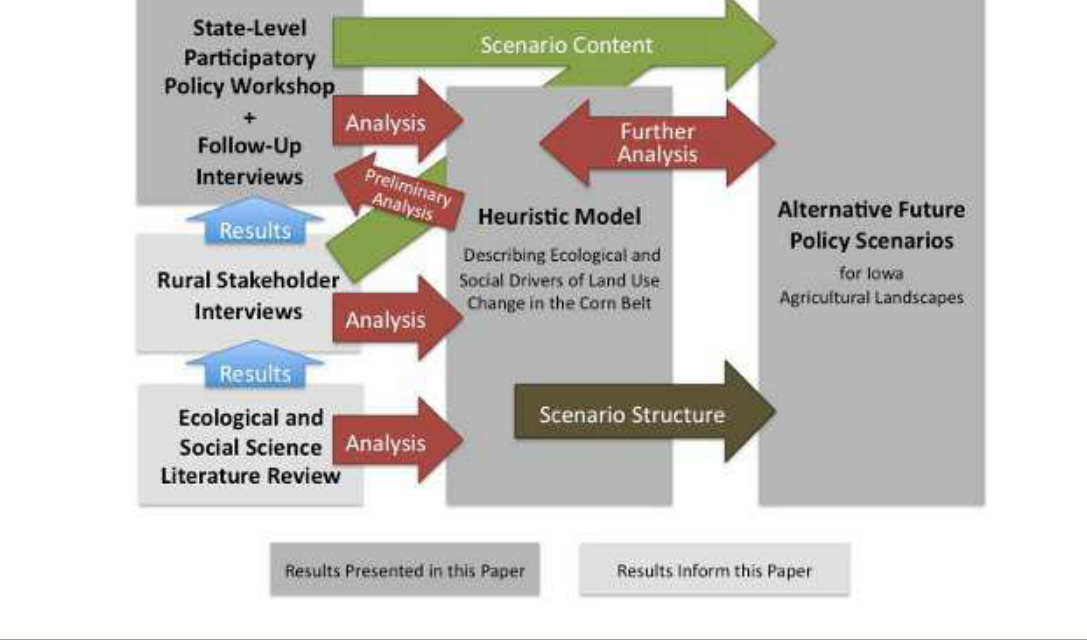
Fig. 2. The heuristic model and scenarios presented in this paper were built upon data from several stages of a larger research